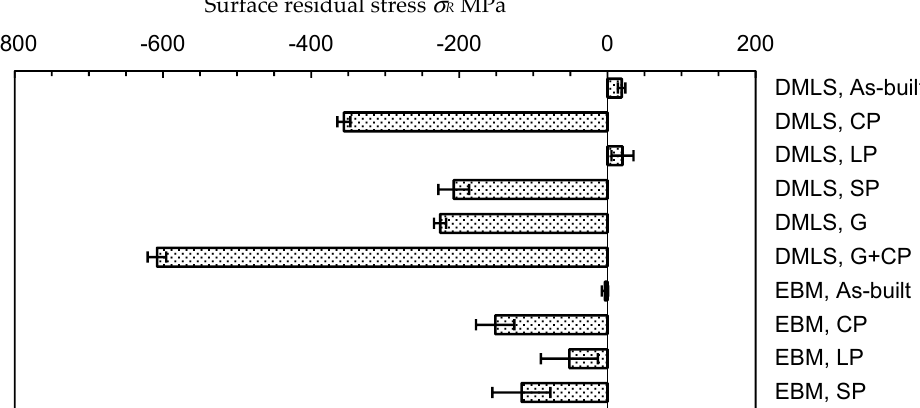
Figure 9. Surface residual stress of the as-built Ti6Al4V manufactured by DMLS and EBM and the Ti6Al4V manufactured by DMLS and EBM through cavitation peening (CP), laser peening (LP), shot peeing (SP), grinding (G), and cavitation peening after grinding (G + CP).